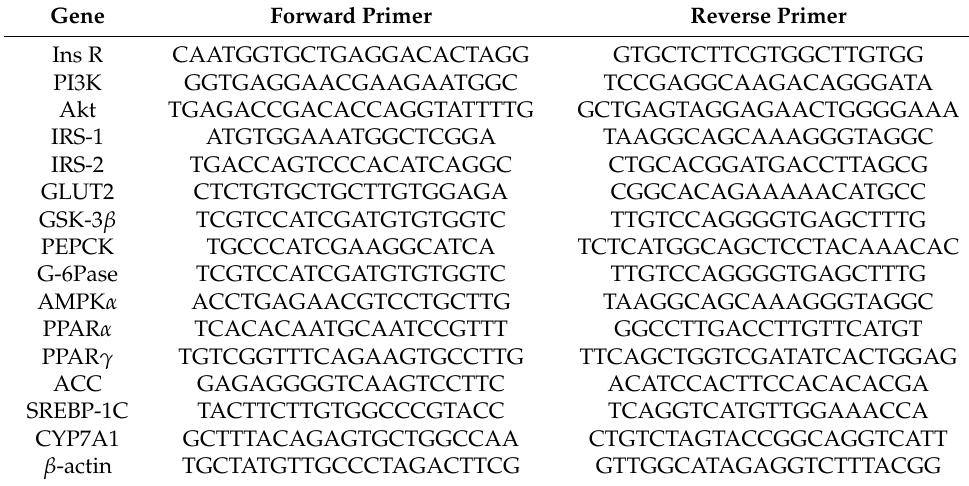
Table 1. Primer sequences for real-time